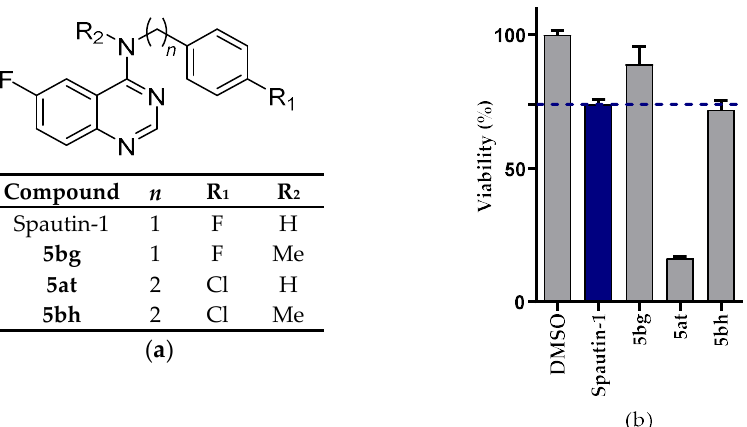
Figure 12. ( a ) Spautin-1 analogue 17 bearing the benzimidazole core; ( b ) viability assay (5 µ M) with Spautin-1 as reference.